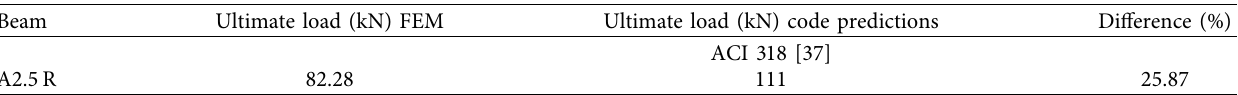
Table 11: Comparisons between the FEM results and the theoretical code prediction of the ultimate load at failure for beam A2.5 R. Beam